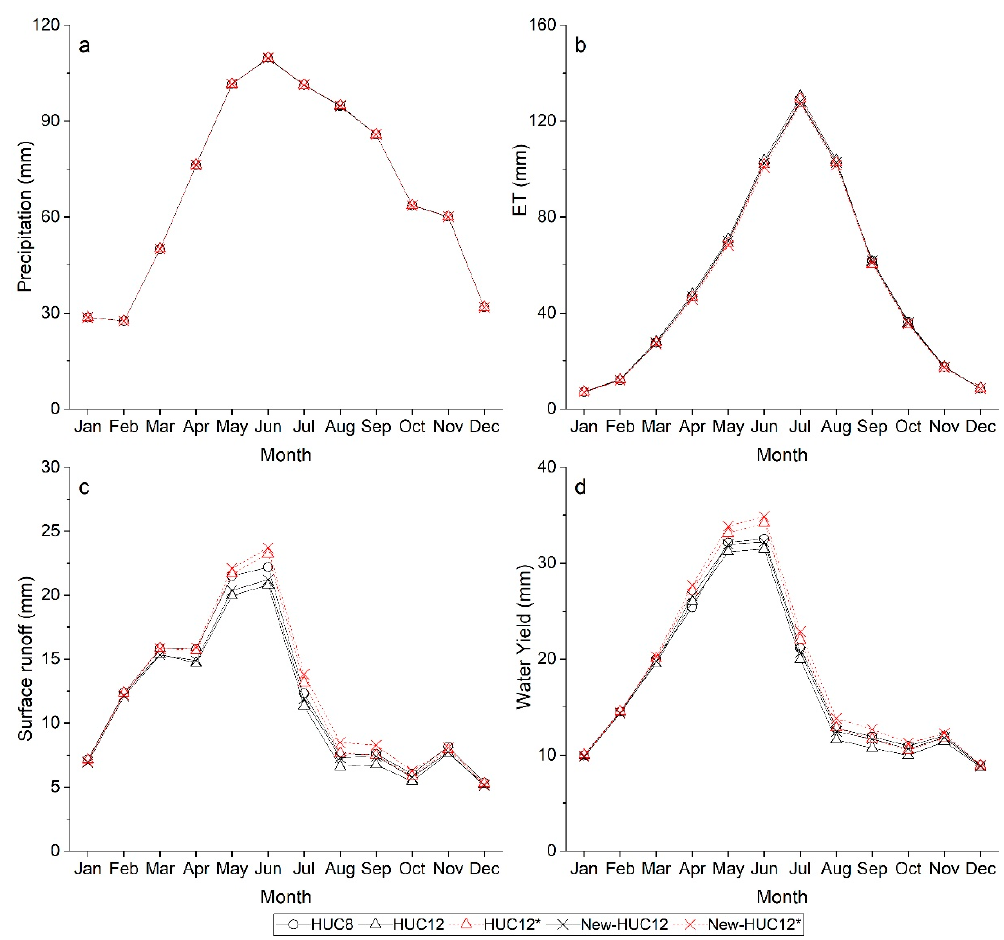
Figure 9. Mean monthly hydrologic components across the UMRB in response to five scenarios during the period from 1983 to 2005 for ( a ) precipitation (mm), ( b ) ET (mm), ( c ) surface runoff (mm) and ( d ) water yield (mm). Colors denote the climate dataset used: black is the PRISM dataset, red is the PRISM* dataset.